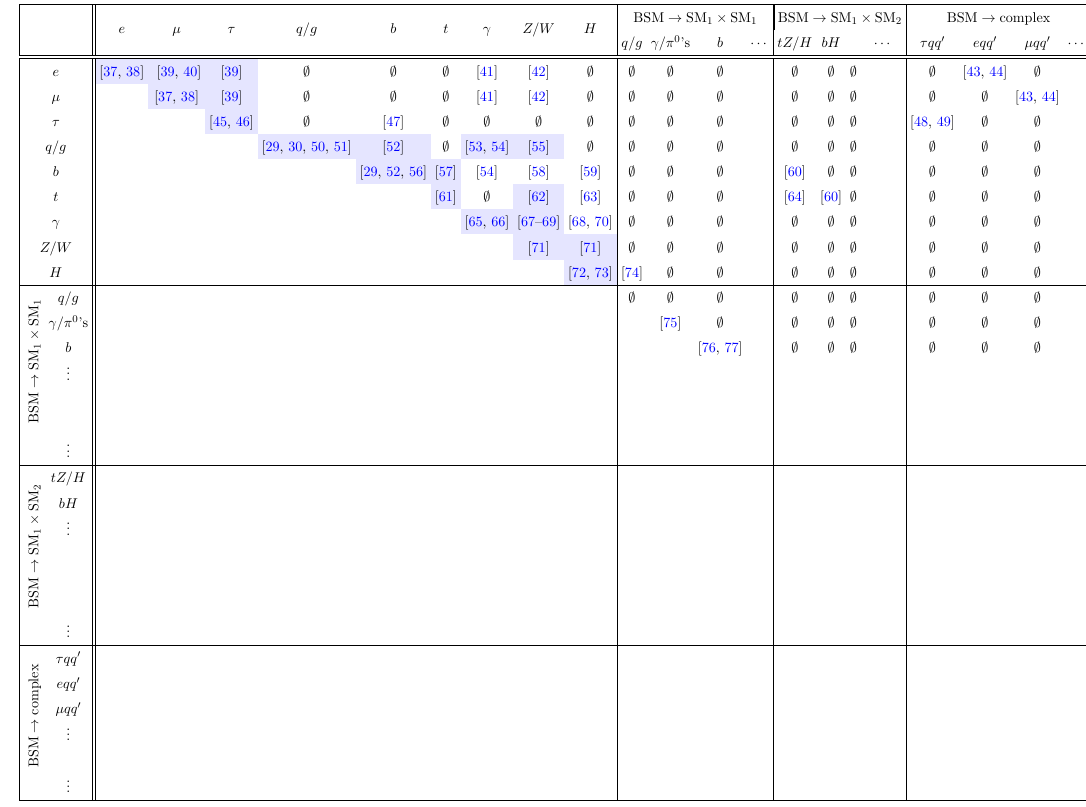
Table 14 . References to existing searches for two-body resonances, where one decay product is from the (cid:12)rst column and one is from the (cid:12)rst row. Only the most recent searches are considered. The box BSM ! SM 1 (cid:2) SM 2 represents cases where the primary resonance decays to a BSM particle, which itself decays into two SM particles that are not the same. Colored cells indicate p searches that were covered by s = 8 TeV searches reported in ref.